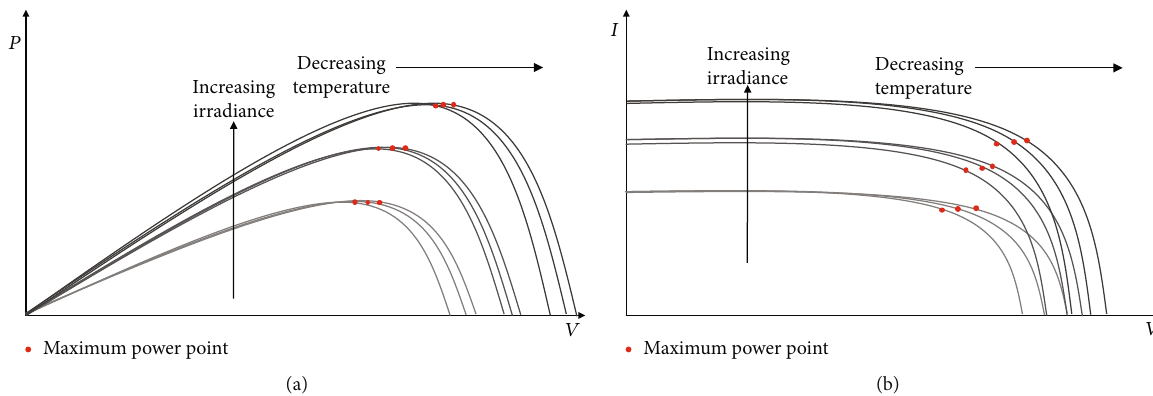
Figure 1: Illustration of photovoltaic characteristics under di ff erent irradiance and temperature: (a) power-voltage characteristic curve; (b) current-voltage characteristic